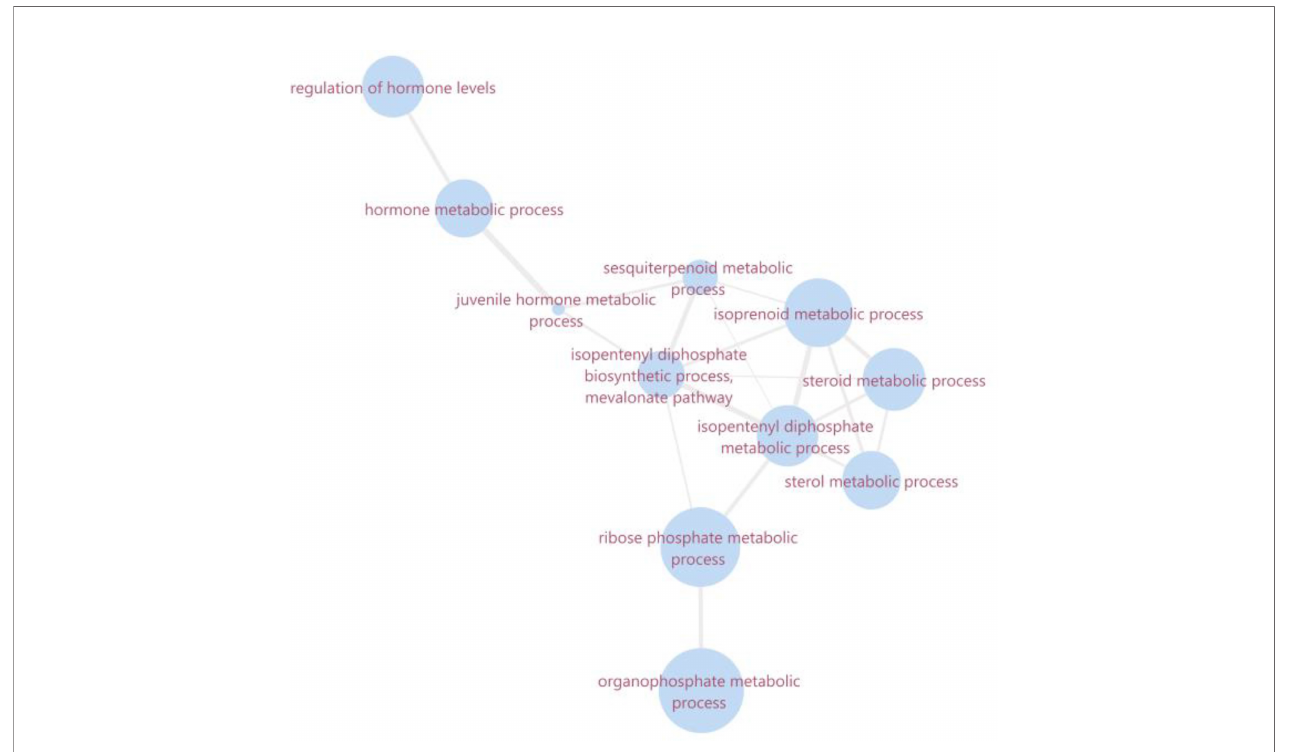
FIGURE 4 | Ontology network of summarized enriched biological processes related to mevalonate kinase and farnesol dehydrogenase. The size of the bubble corresponds to the LogSize value for the GO Term. The overview and the interaction network were obtained in software revigo and cytoscape 3.8.0,